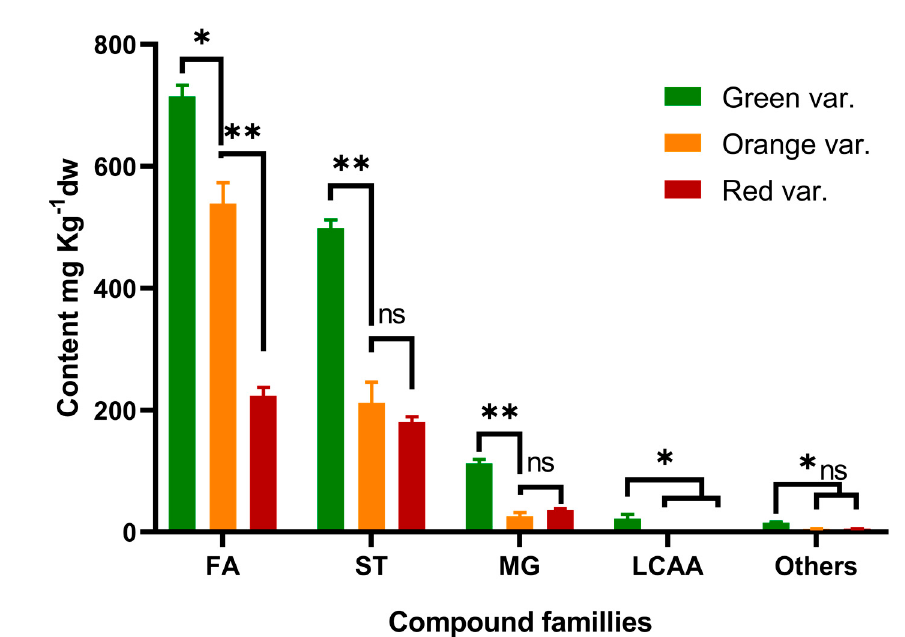
* Each value represents the mean of six aliquots from three extracts of each sample (standard deviation lower than 5%). Abbreviations: ND, not detected; RT, retention time; var.: variety. Tukey’s HSD test; difference in the letter in a line indicates a significant difference at p ≤ 0.05 between the varieties.